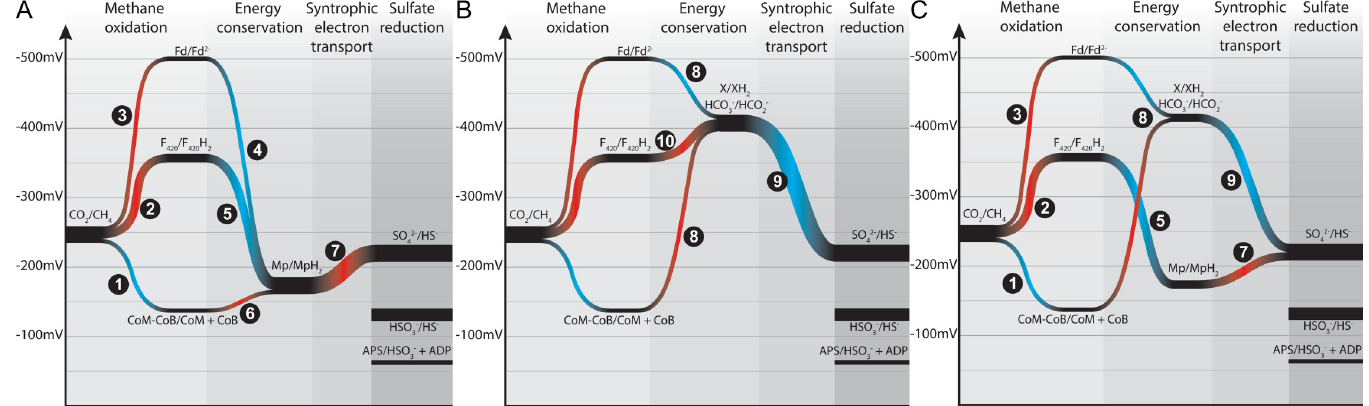
Fig 19. Energetics of mixed electron transfer. Energy flow diagrams showing the redox potential (y-axis) of electrons as they travel from methane through the ANME energy metabolism to the SRB partner (x-axis is reaction progression). Width of paths correspond to number of electrons. Endergonic electron flow (uphill) shown in red, exergonic (downhill) in blue. Steps labeled with numbers are carried out by the following enzymes: 1: Mcr, 2: Mer/Mtd, 3: Fwd/Fmd, 4: Rnf, 5: Fpo/Fqo, 6: HdrDE, 7: Mco and ANME-MHC, 8: HdrABC and ANME-specific FrhB, FdhA, 9: uncatalyzed diffusion of electron carrier, 10: FdhAB, possibly confurcation through HdrA complexes. X/XH 2 represent a hypothetical low-potential electron carrier that could be used as a diffusive electron shuttle. ( A ) Electron transfer based entirely on EET from the methanophenazine pool. ( B ) Electron transfer based entirely on soluble electron shuttle produced in the cytoplasmic space. ( C ) Mixed model with half of the electrons passing through each pathway. ANME, anaerobic methanotrophic; EET, extracellular electron transfer; Fpo, F 420 H 2 :methanophenazine oxidoreductase; Fqo, F 420 H 2 : quinone oxidoreductase complex; Mco, methanophenazine-cytochrome c oxidoreductase; Mcr, methyl-coenzyme M reductase; Mer, methylenetetrahydromethanopterin reductase; MHC, multiheme c -type cytochrome; Mtd, N5,N10-methylene-H 4 MPT dehydrogenase; Rnf, Rhodobacter nitrogen fixation; SRB, sulfate-reducing bacteria.